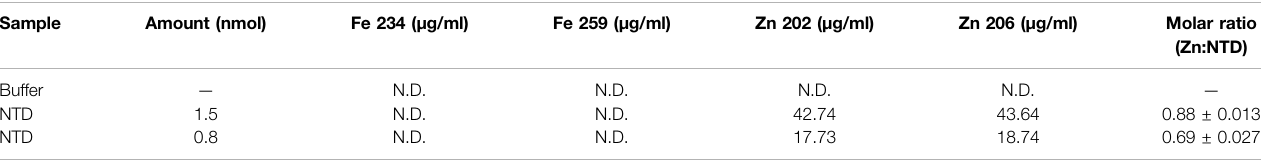
TABLE1| Inductively CoupledPlasmaOpticalEmissionSpectrometry ofthe Dm NTDaftermetalextraction andsubstitutioncon fi rmstheabsenceofiron,andthepresence of zinc in two independent preparations.